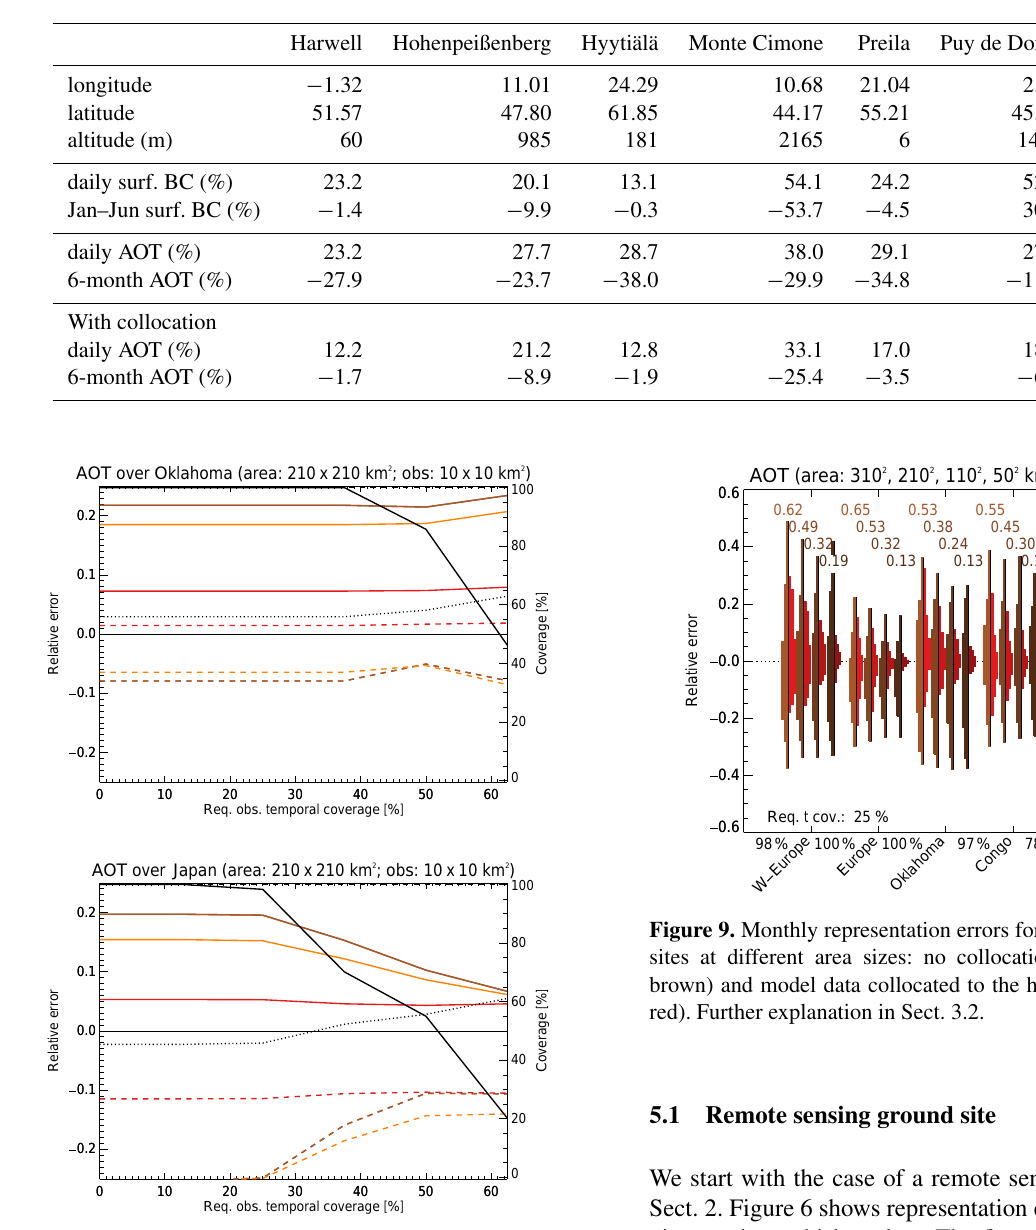
Figure 8. Monthly mean (dashed) and RMS (solid) of representa- tion errors for remote sensing ground sites as a function of required temporal coverage: no collocation (brown), area data collocated to the day of observations (bright orange) and area data collocated to the hour (red). Further explanation in Sect. 3.2.